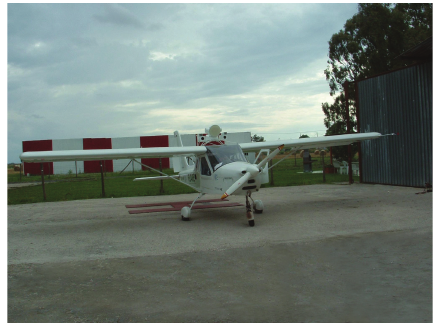
Figure 1: ODID system installed onboard